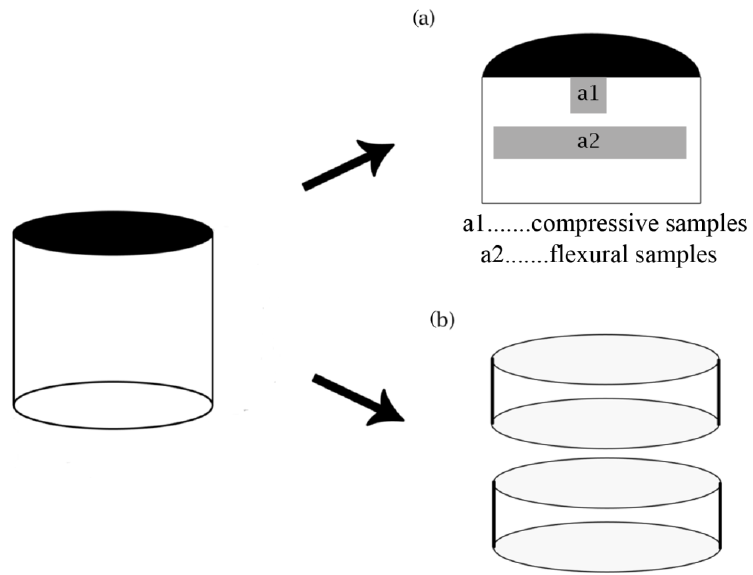
Figure 1. Shape and locations of the samples intended for the characterization of ( a ) the microstructure, ( a1 ) compressive, ( a2 ) flexural and ( b ) corrosion properties.